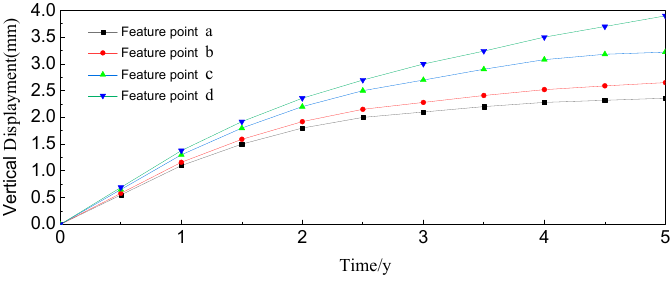
Figure 13. Settlements of each characteristic point when t = 5 years.